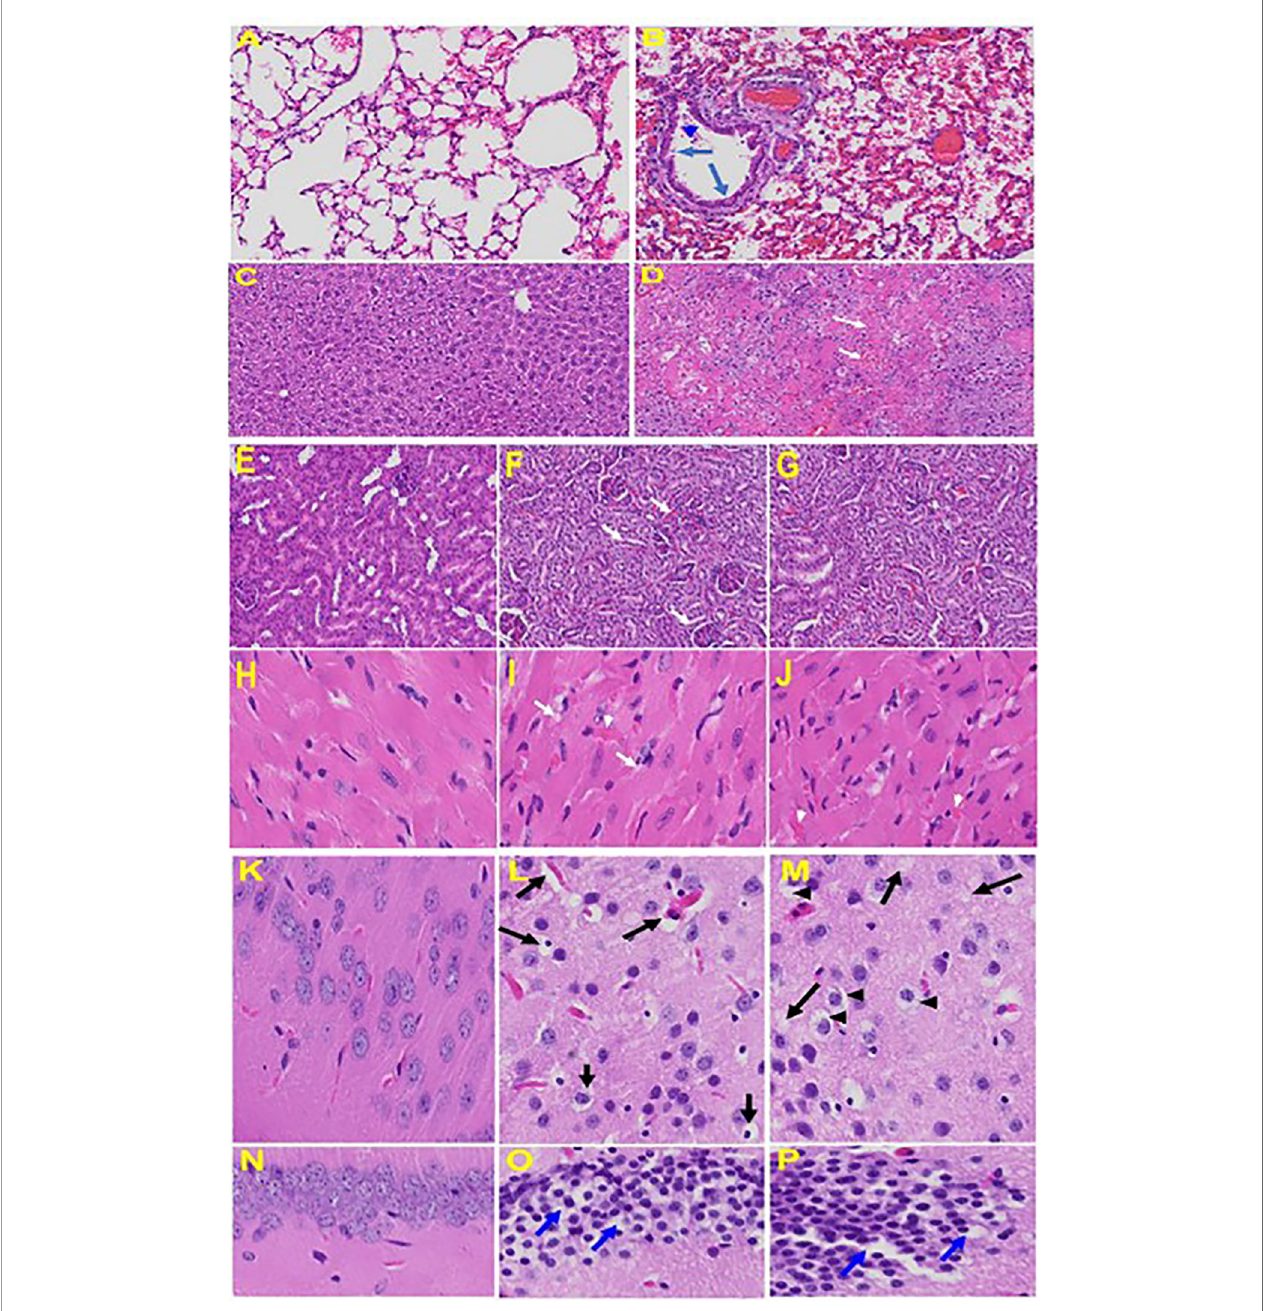
FIGURE 6 | Organs histology in infected and uninfected mice: Representative histological images of haematoxylin and eosin (H&E) stained lung tissue sections of normal mouse (A) and infected mouse lung (B) . MHV-1-infected mice lung shows arterial endothelial swelling (hypertrophy, long arrow), in fl ammation and granular degeneration of cells (short arrow) and migration of leukocytes (arrowhead) into lung. Peribronchiolar interstitial in fi ltration, bronchiole epithelial cell necrosis and necrotic cell debris within alveolar lumens, alveolar exudation, in fi ltration, hyaline membrane formation and alveolar hemorrhage with red blood cells within the alveolar space and interstitial edema were observed in MHV-1-infected mice. Liver, kidney, heart, and brain tissue degenerative changes were observed in MHV-1-infected mice. MHV-1-infected mice at day 6 showed liver hepatocytes degeneration, severe cells necrosis [ (D) , long arrows] and hemorrhagic changes (short arrows) when compared to uninfected mice (C) ; Uninfected kidney (E) and tubular epithelial cells degenerative changes and vacuolation, and peritubular vessels congestion (F, G) ; Severe interstitial edema (arrows), vascular congestion and dilation (arrow heads) and red blood cells in fi ltrating between degenerative myocardial fi bers were seen in the MHV-1 infected mice heart (I, J) , as compared to uninfected mice (H) . Vacuolation of cerebral matrix [arrows, (L, M) ] and cytotoxic edema [arrow heads, (L, M) ], congested blood vessels with perivascular edema [long arrows, (L, M) ], as well as cytotoxic edema (short arrows) were seen in MHV-1infected mice brain cortex, and in hippocampus (O&P). Reproduced with permission from Paidas et al, Viruses; Published by MDPI, 2021.